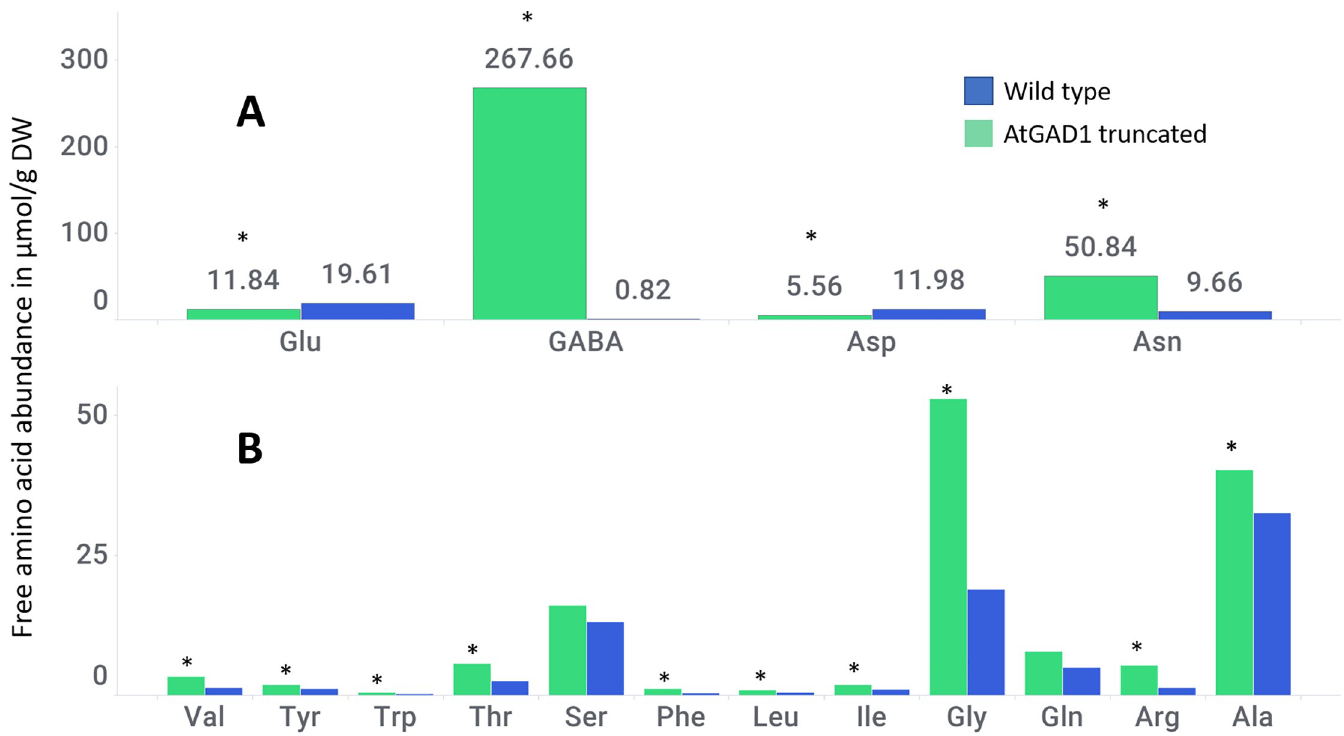
Fig 4. Truncated AtGAD1- Δ CaMD expressing transgenic 150-day-old corn plants show increased accumulation of GABA and other amino acids. Values are the average of five events. Green bars represent transgenic plants, blue bars represent wild-type plants. An asterisk marks those lines significantly different than wild type (p < 0.05).